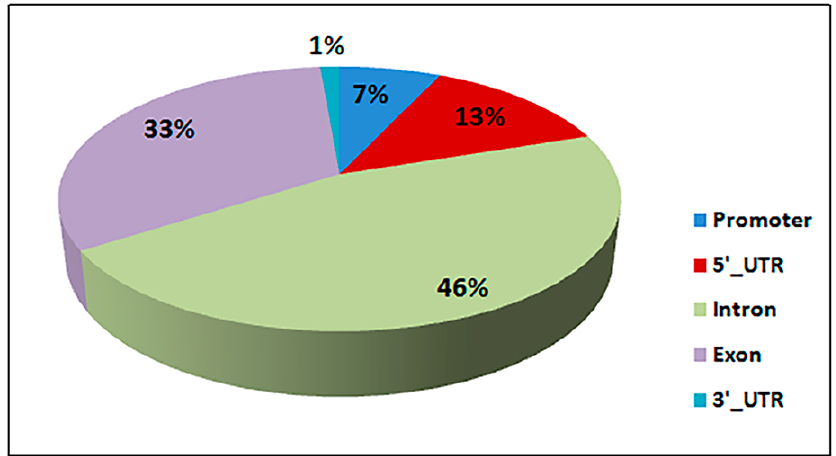
Figure 4. Distribution of differentially methylated regions (DMRs).